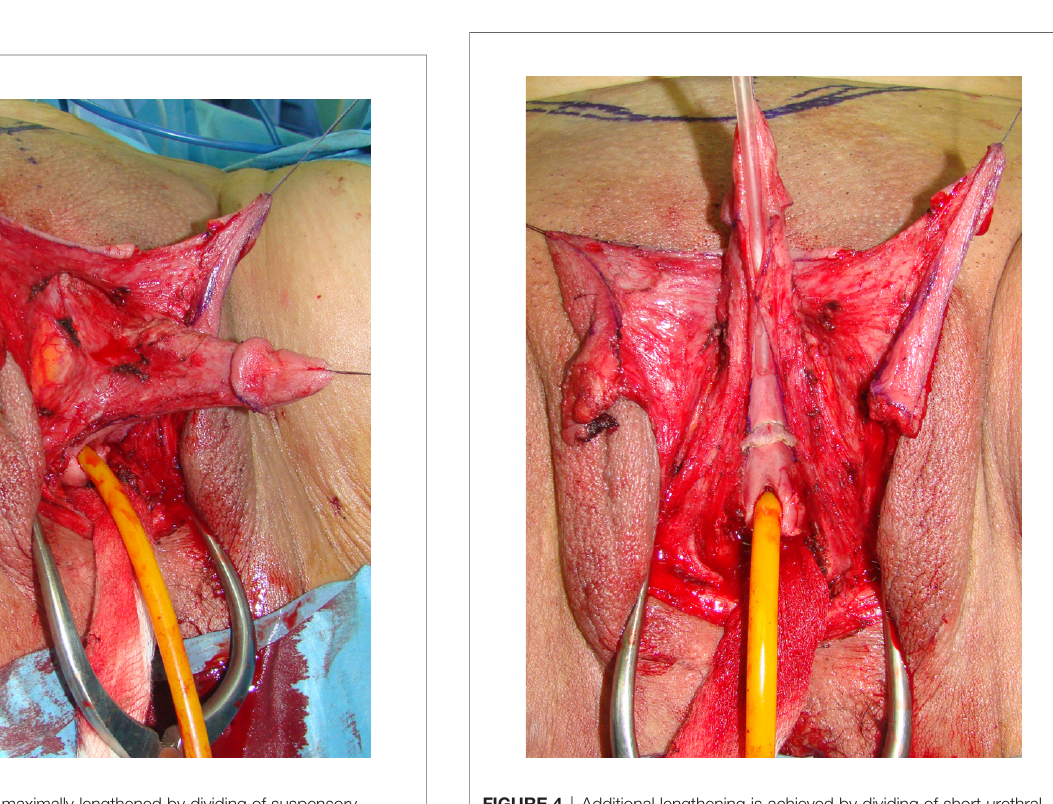
FIGURE 4 | Additional lengthening is achieved by dividing of short urethral plate,